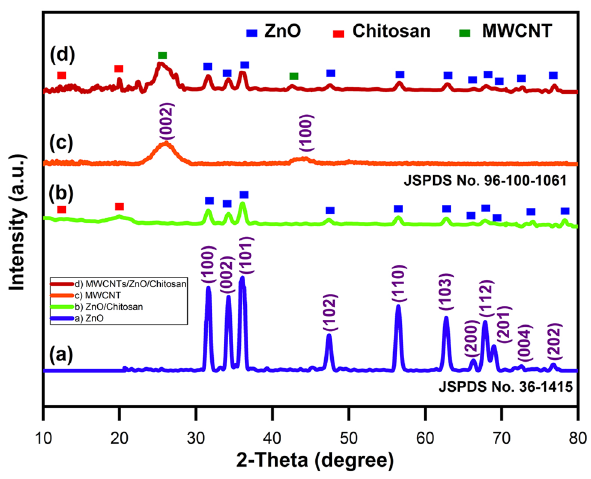
Figure 6. XRD patterns of ( a ) pure ZnO, ( b ) ZnO/Chitosan nanocomposite, ( c ) pure MWCNTs and ( d ) MWCNTs/ZnO/Chitosan